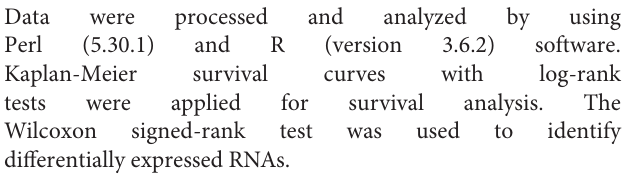
between immune cell infiltration and clinicopathological characteristics was